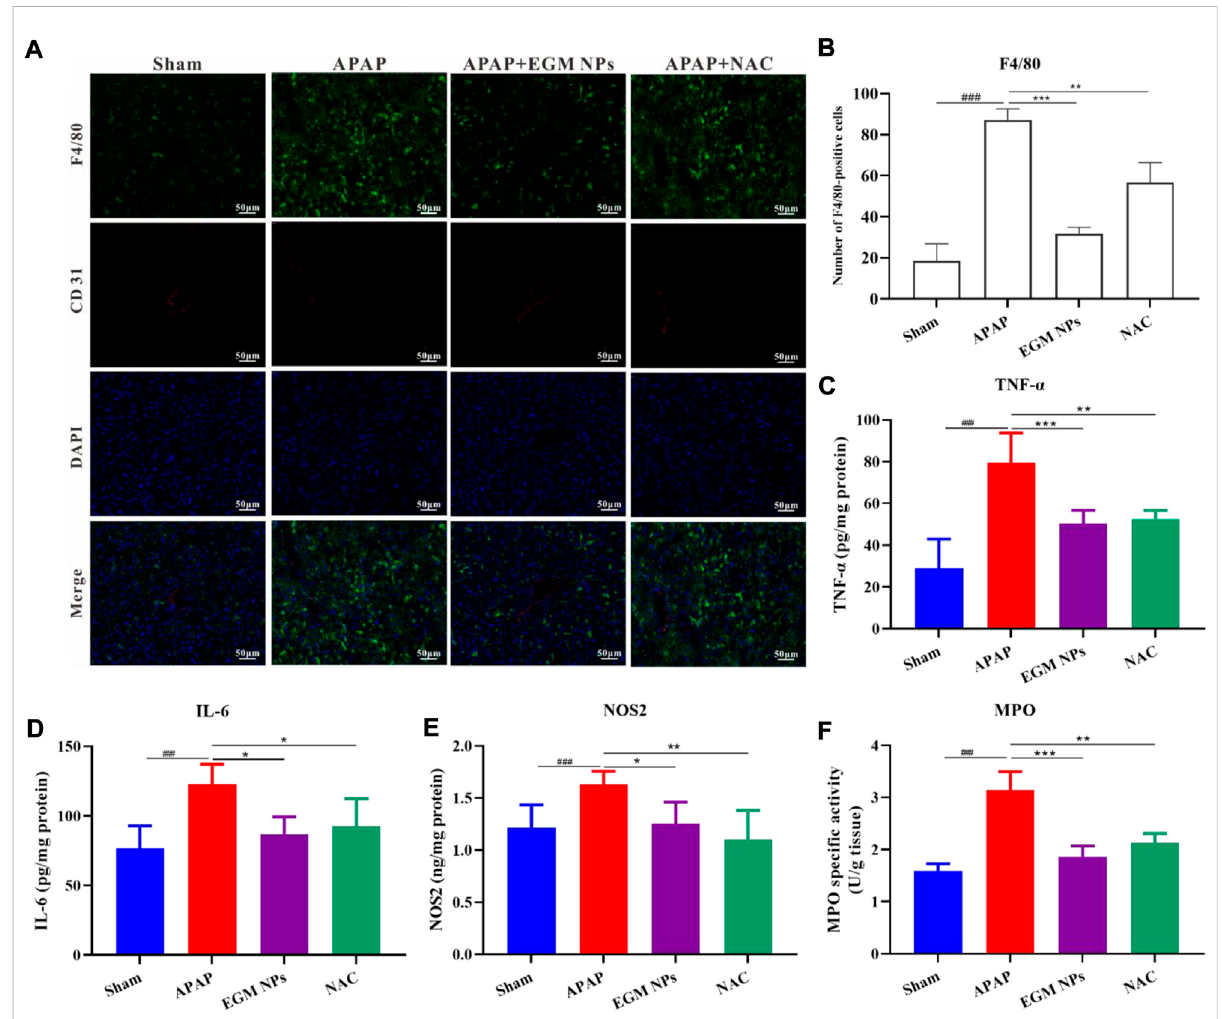
FIGURE 6 EGMNPsinhibitin fl ammationduring APAP-induced liverinjury. (A) F4/80staining(green fl uorescence),CD31 (red fl uorescence)staining,DAPI (blue fl uorescence) staining, and their merge images of liver tissues from each group. Scale bar: 50 μ m. (B) Quanti fi cation of F4/80-positive cells in (A) . Data represent means ± S.D. from three independent replicates. (C – F) TNF- α (C) , IL-6 (D) , NOS2 (E) , and MPO (F) levels measured in liver tissue homogenates from each group. Data represent means ± S.D. from six independent replicates. (* p < 0.05, ** p < 0.01, *** p < 0.001 vs . APAP group; ### p < 0.001 vs . Sham